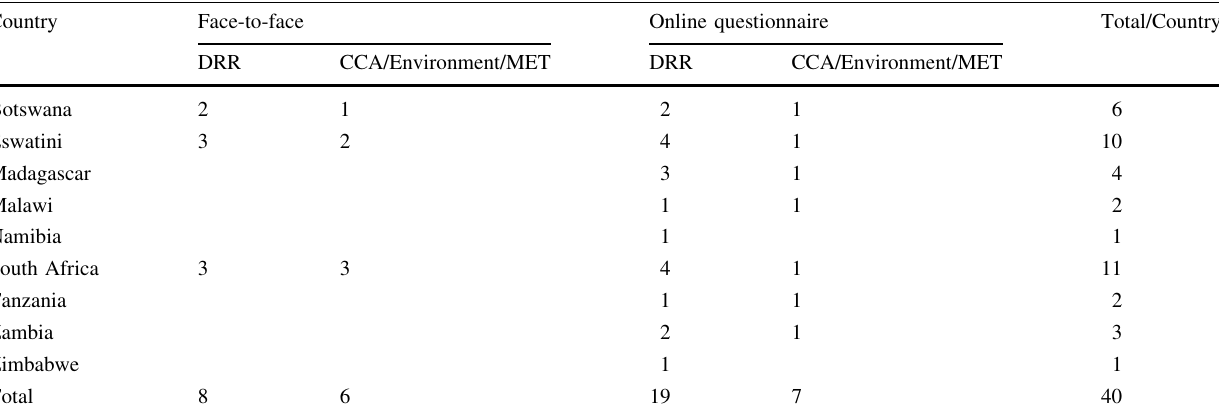
Table 1 Breakdown of respondents in the Southern African Development Community study Country Face-to-face Online questionnaire